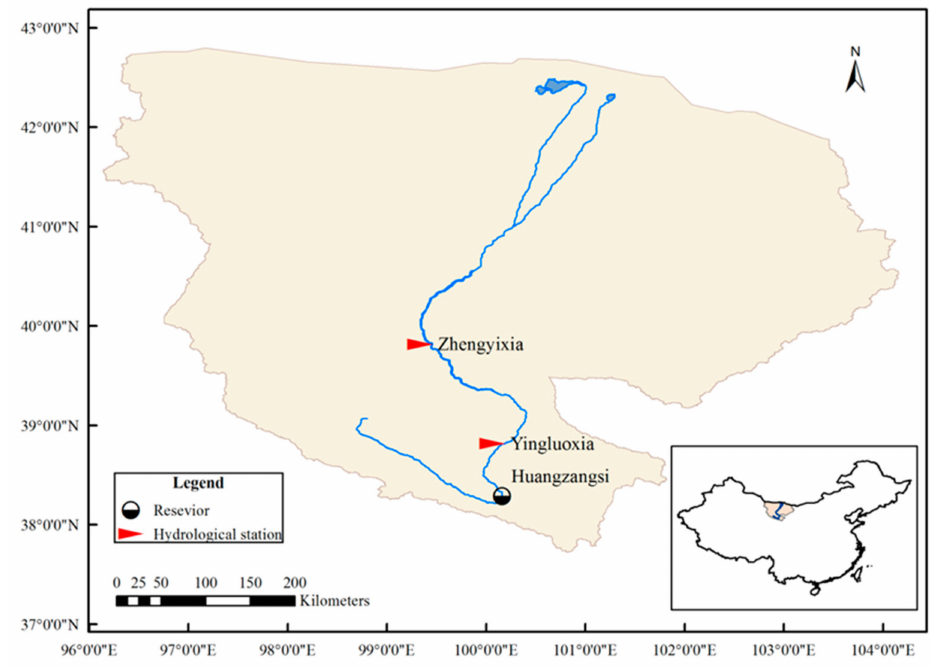
Figure 4. Location of the study area.